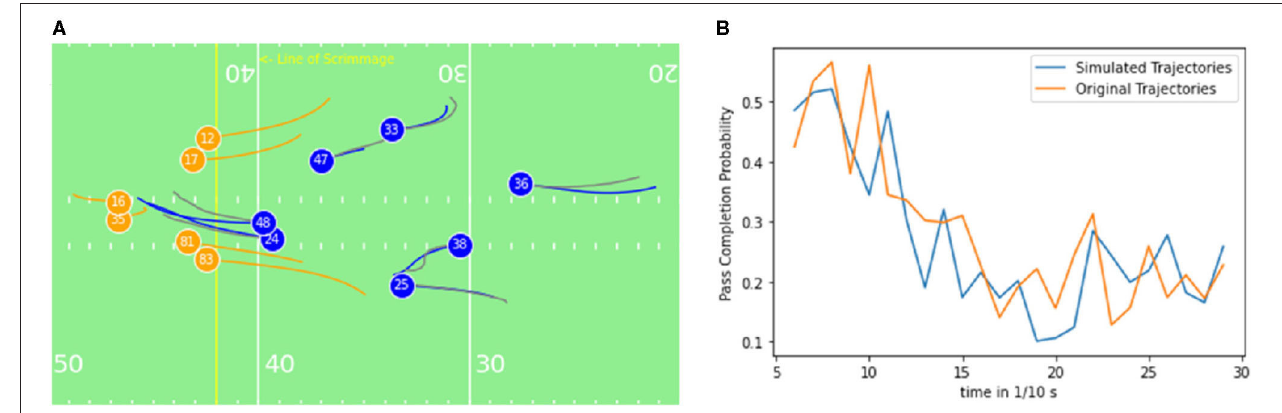
FIGURE 8 | (A) Exemplary short play ( ≈ 3s): The Quarterback (16) throws a short pass to a receiver (12) on the left side of the field. Offensive players are illustrated in blue, defenders orange and ghosted trajectories in gray color. The initial position of the players is represented by the player shirt number. (B) Pass completion probability over the course of the play for the ghost/simulated trajectories and true/original movements.